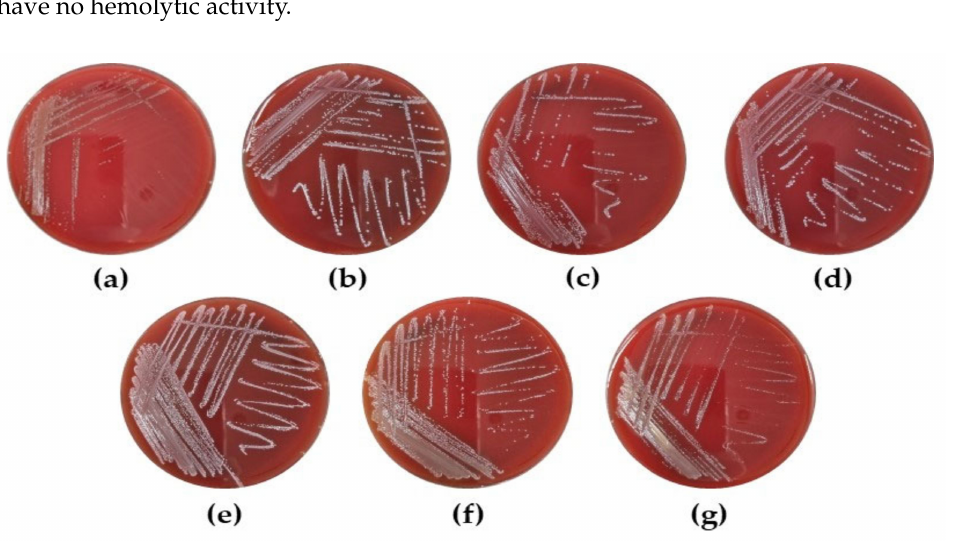
Figure 6. Hemolysis of LAB strains. ( a ) L. reuteri MG5462, ( b ) Lc. lactis MG4668, ( c ) Lc. lactis MG5278, ( d ) Lc. lactis MG5474, ( e ) L. fermentum MG4263, ( f ) L. fermentum MG4268, and ( g ) L. fermentum